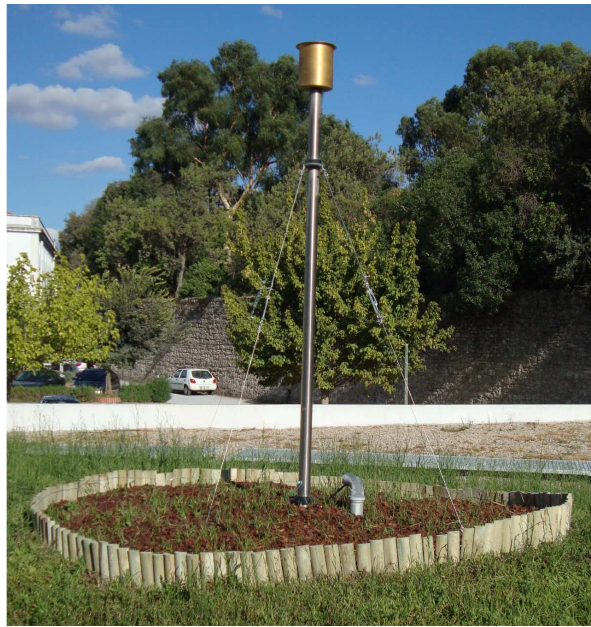
Fig. 6. Photograph of the VAE sensor installed at the University of ´Evora. The inset is a zoom into the head of the